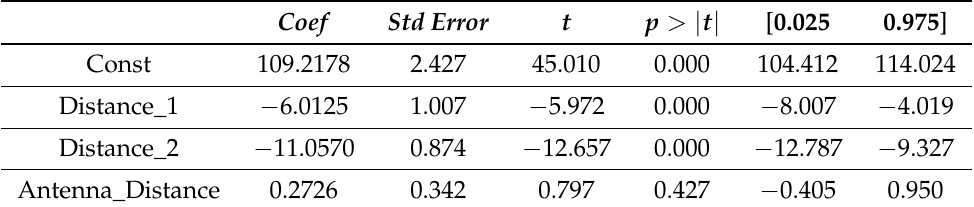
Table 6. Ordinary least squares (OLS) regression